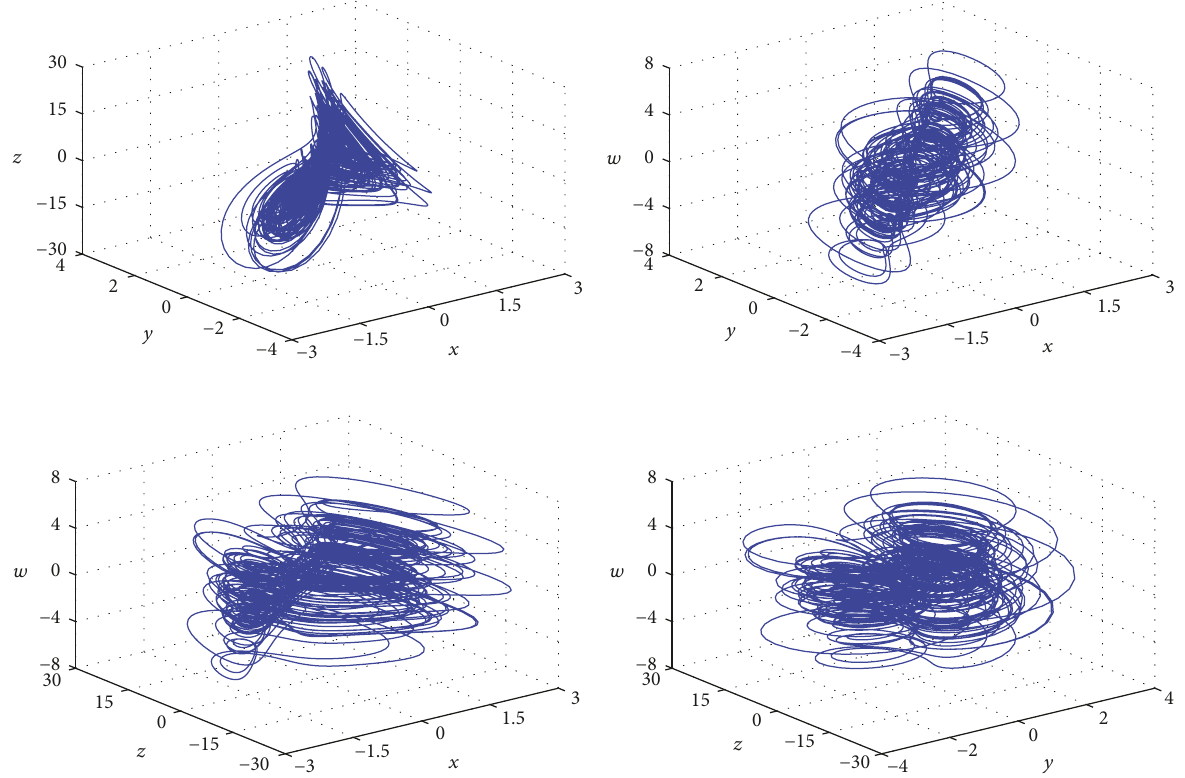
Figure 3: Hyperchaotic attractor of four-dimensional self-exciting homopolar disc dynamo system (2) without equilibria for 𝑟 = 8 , 𝑔 = 35 , 𝑘 = 3 , and 𝑚 = 0.5